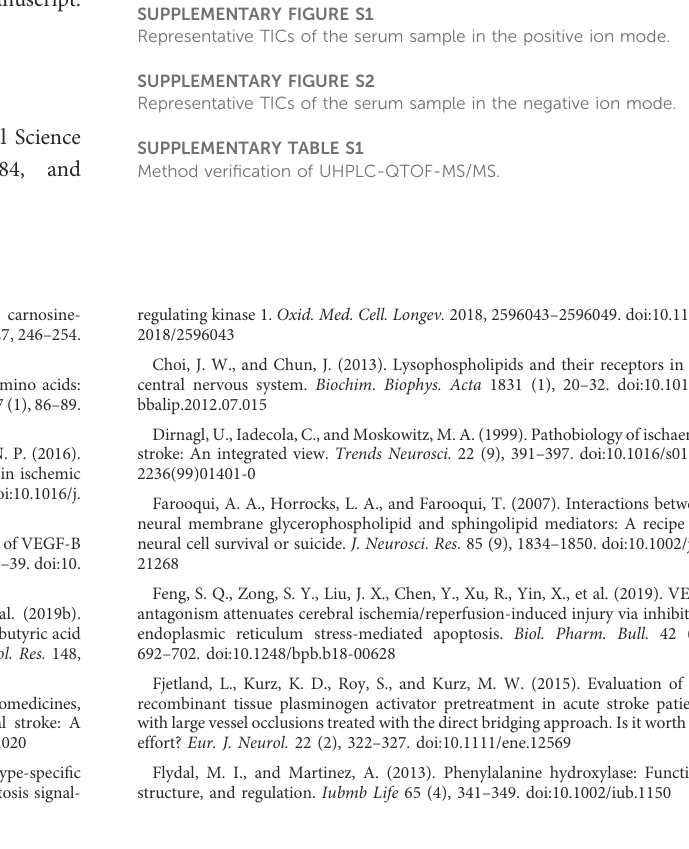
SUPPLEMENTARY FIGURE S1 Representative TICs of the serum sample in the positive ion mode. SUPPLEMENTARY FIGURE S2 Representative TICs of the serum sample in the negative ion